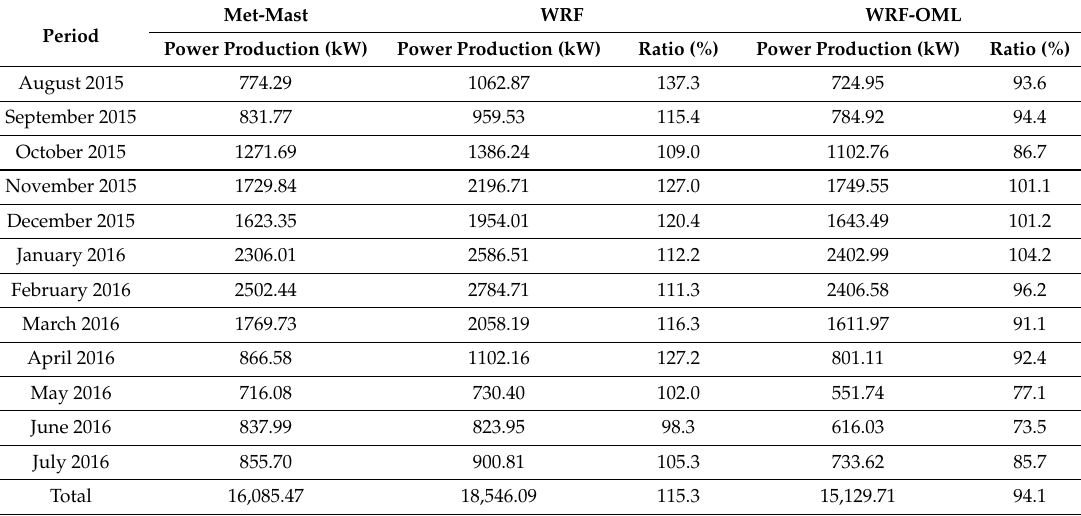
Table 5. Monthly power production from the met-mast observation data and from the prediction data of the